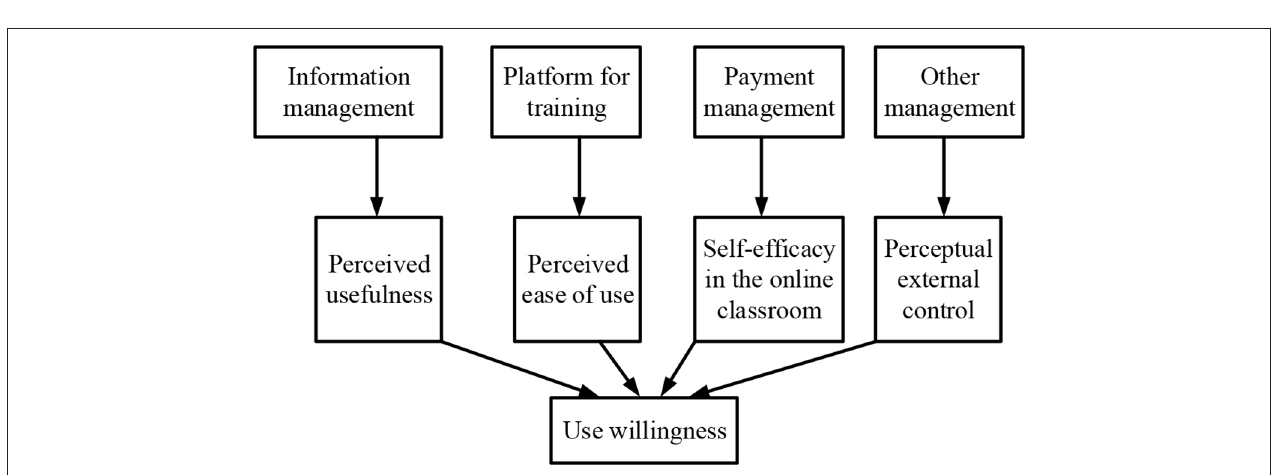
FIGURE 2 | Technical roadmap.